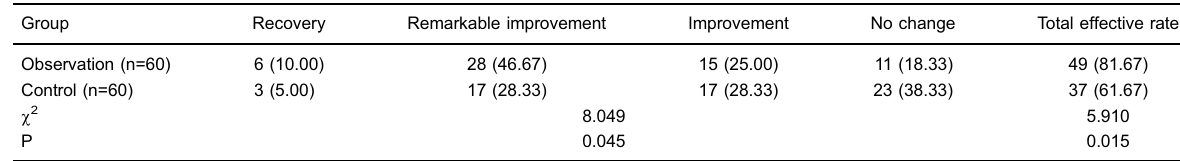
Table 2. Comparison of ef fi cacy based on the National Institutes of Health Stroke Scale of patients with acute cerebral infarction treated with alteplase (observation group) or batroxobin (control group). Group Recovery Remarkable improvement Improvement No change Total effective rate Observation (n=60)